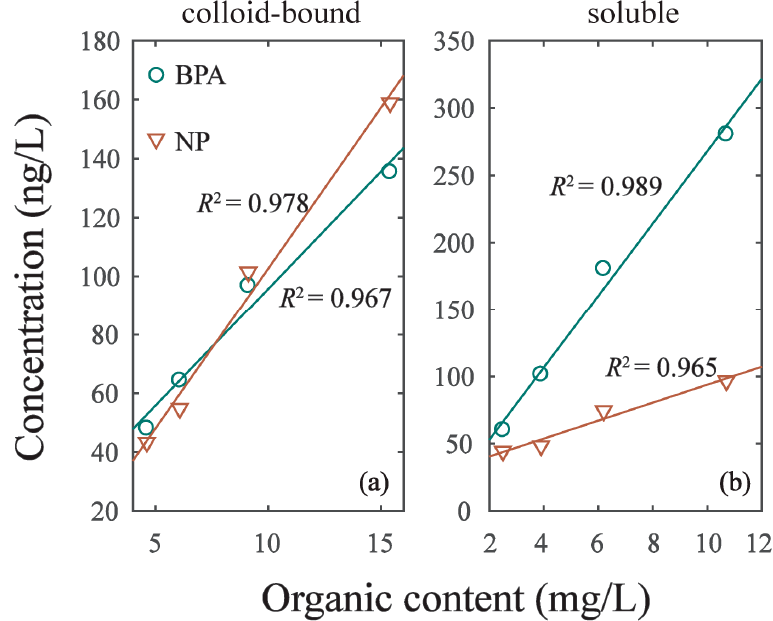
Figure 5. The correlation of EDCs concentration in two phases and its organic content. ( a ) Colloid-bound phase. ( b ) Soluble phase.